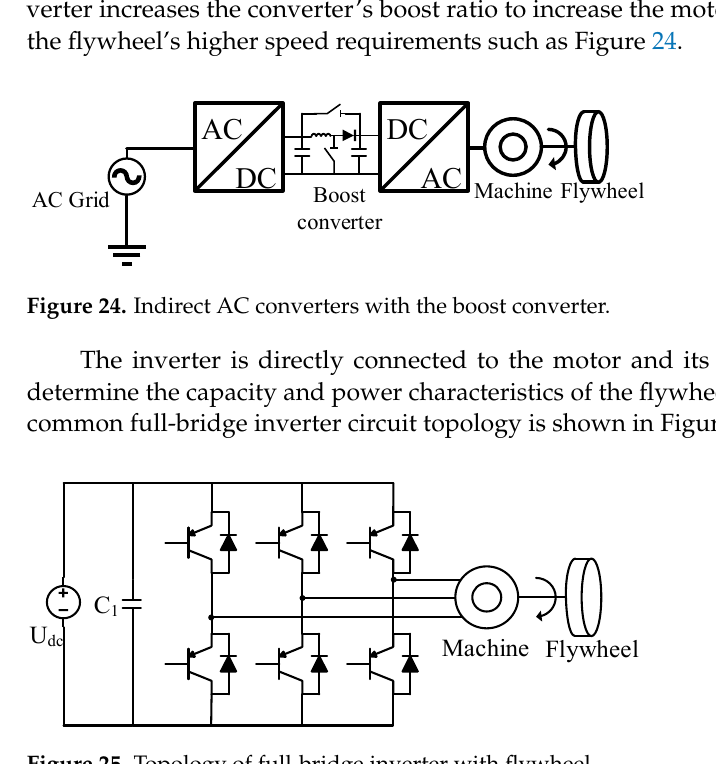
Figure 23. Indirect AC converters with flywheel.